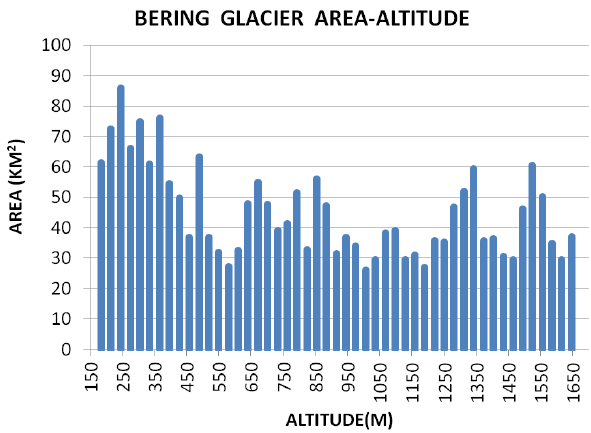
Fig. 2. Area-altitude distribution of Bering Glacier. There are 49 Figure 2 . Area-altitude distribution of Bering Glacier. There are 49 32 altitude intervals spaced at 30.6m (100feet), ranging from 150 to altitude intervals spaced at 30.6 m (100 feet), ranging from 150 to 1650 33 1650m in elevation. The total area of this segment is 2193km 2 and meters in elevation. The total area of this segment is 2193 km 2 and 34 includes the most active (surging) area of the glacier. These area 35 includes the most active (surging) area of the glacier. These area dis- distributions do not cover the full range of the glacier area that includes 36 tributions do not cover the full range of the glacier area that includes the Bagley Ice Field, but represent the most active (surging) part of the 37 the Bagley Ice Field. Latitude 60.302 ◦ N Longitude 143.20 ◦ glacier. Latitude 60.302 N Longitude 143.20 W 38 39